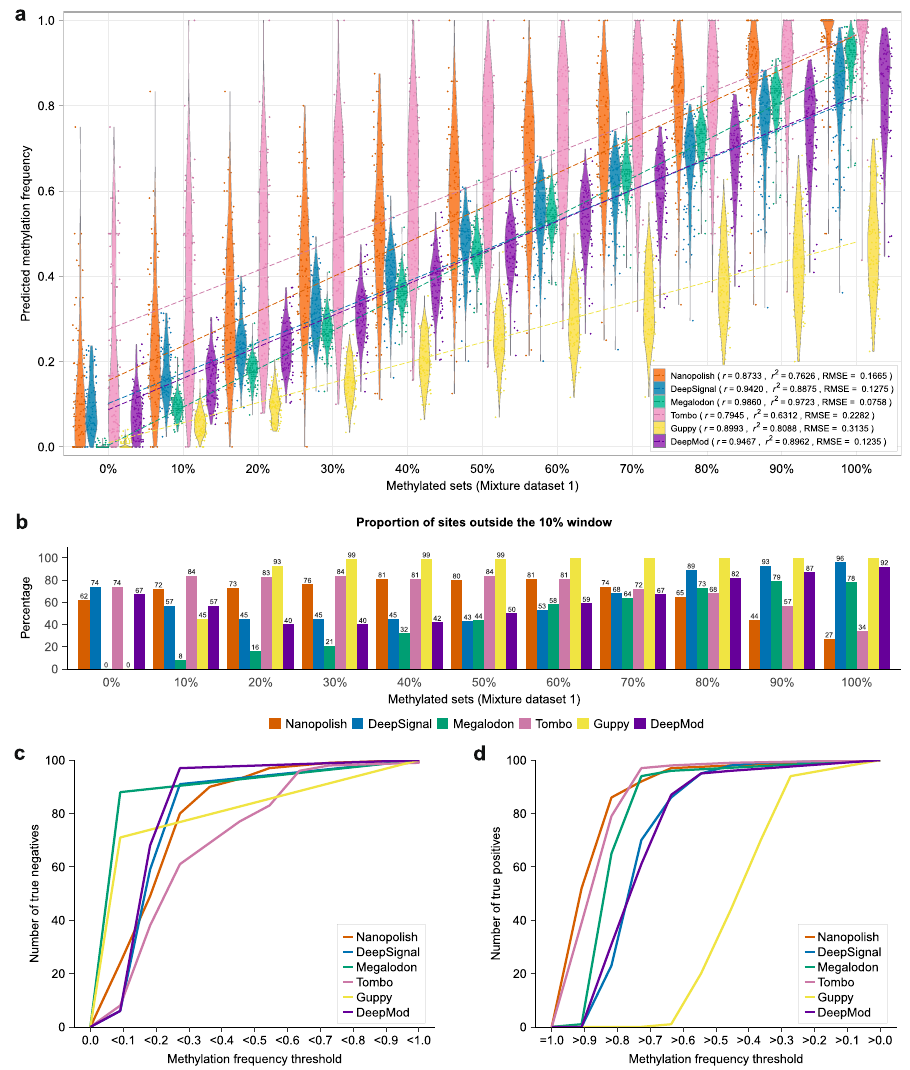
Fig. 2 Accuracy analysis per CpG site on control mixture dataset 1. a Violin plots showing the predicted methylation frequencies ( y axis) for each control mixture set with a given proportion of methylated reads ( x axis). The Pearson ’ s correlation ( r ), coef fi cient of determination ( r 2 ), and root mean square error (RMSE) are given for each tool. b For each method, we indicate the proportion of sites predicted outside a 10% window around the expected methylation proportion, i.e., each predicted site in the m% dataset was classi fi ed as “ outside ” if its predicted percentage methylation was outside the interval [(m − 5)%, (m + 5)%] for intermediate methylation values, or outside the intervals [0,5%] or [95%, 100%] for the fully unmethylated or fully methylated sets, respectively. The percentage is indicated on top of each bar, except for 100%. c Empirical cumulative distribution function (ECDF) plot showing the number of true negatives ( y axis) for each tool according to different thresholds for the predicted methylation frequency below which a site was called unmethylated ( x axis), using the dataset of 100 fully unmethylated sites. d ECDF plot showing the number of true positives ( y axis) for each tool according to different thresholds for the predicted methylation frequency above which a site was called fully methylated ( x axis), using the dataset of 100 fully methylated